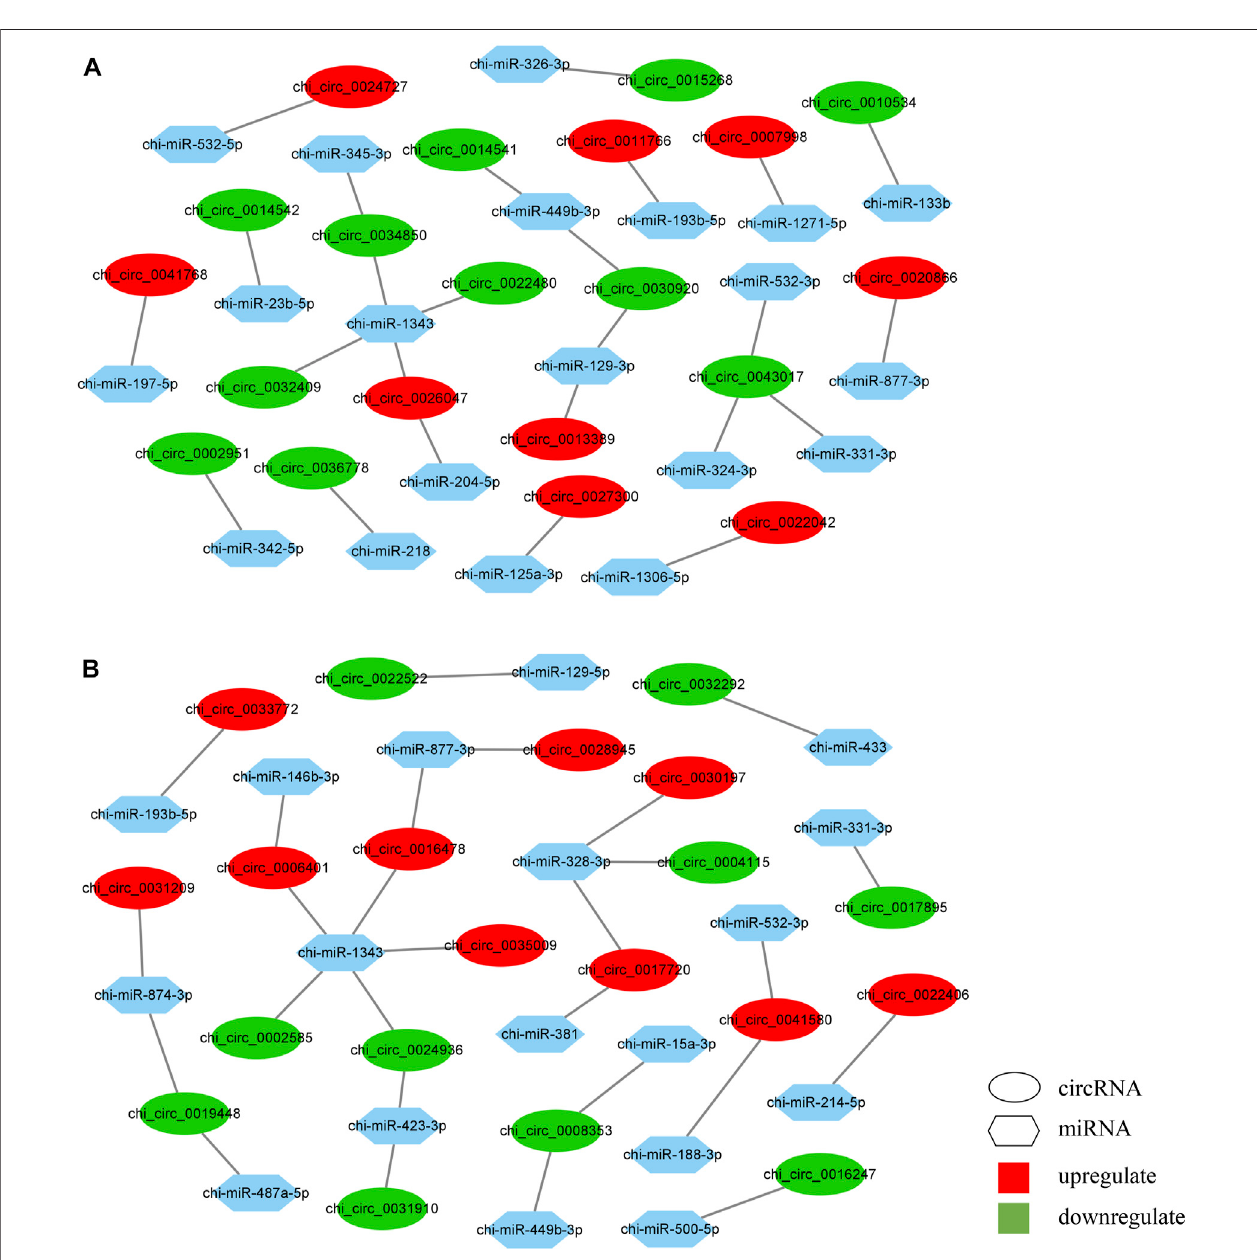
FIGURE 7 | Prediction of microRNA-circular RNA interactive networks. (A) The differentially expressed circular RNAs (DE circRNAs) in high-yielding goats in the follicularphaseversuslow-yieldinggoatsinthefollicularphase (HFvs. LF). (B) Thedifferentiallyexpressed circularRNAs(DE circRNAs) inhigh-yieldinggoats intheluteal phase versus low-yielding goats in the luteal phase (HL vs.